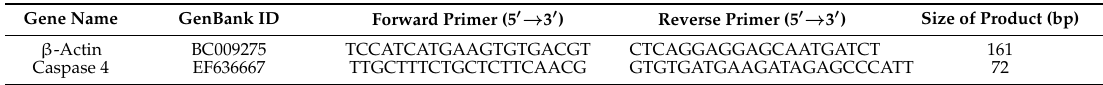
Table 1. Primers used in qRT-PCR